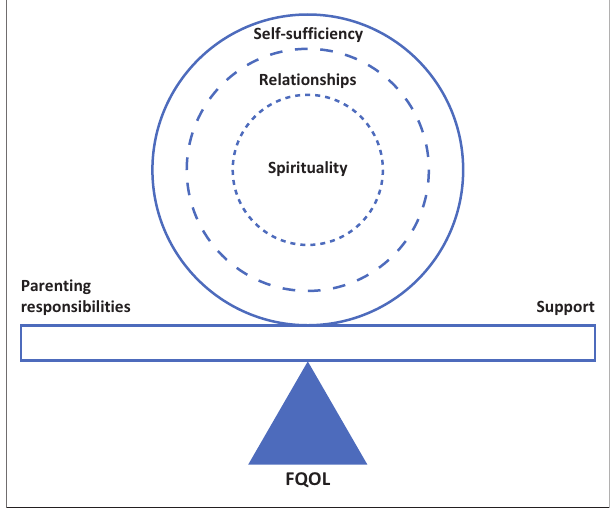
FIGURE 1: Visual representation of family quality of life as described by Ethiopian families of children with disabilities.